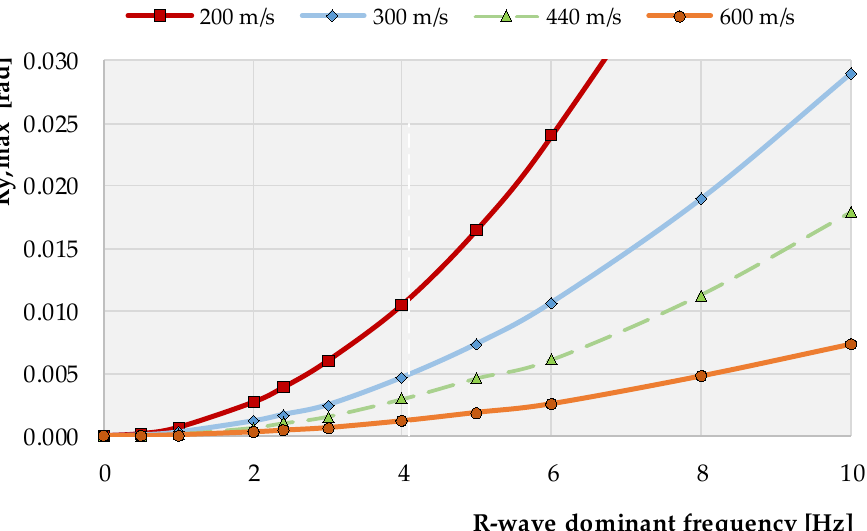
It can be noticed that the total increase in the value of the ratio a/b within the possible values of Poisson’s ratio ν = 0 ÷ 0.5 reached 44.4%; however, the increase in the value of the vertical displacements w was much greater (72%) than the horizontal displacements u , for which the values increased by no more than 19%. From the form of the first derivative of Equation (14) with respect to x, the mutual relationships between the three basic parameters R y , max , f and v R (maximum amplitude of rotation of the elastic half plane’s surface, dominant wave frequency and the wave velocity, respectively) describing the tilt of the instantaneous wave surface were determined and presented in Figure 11.